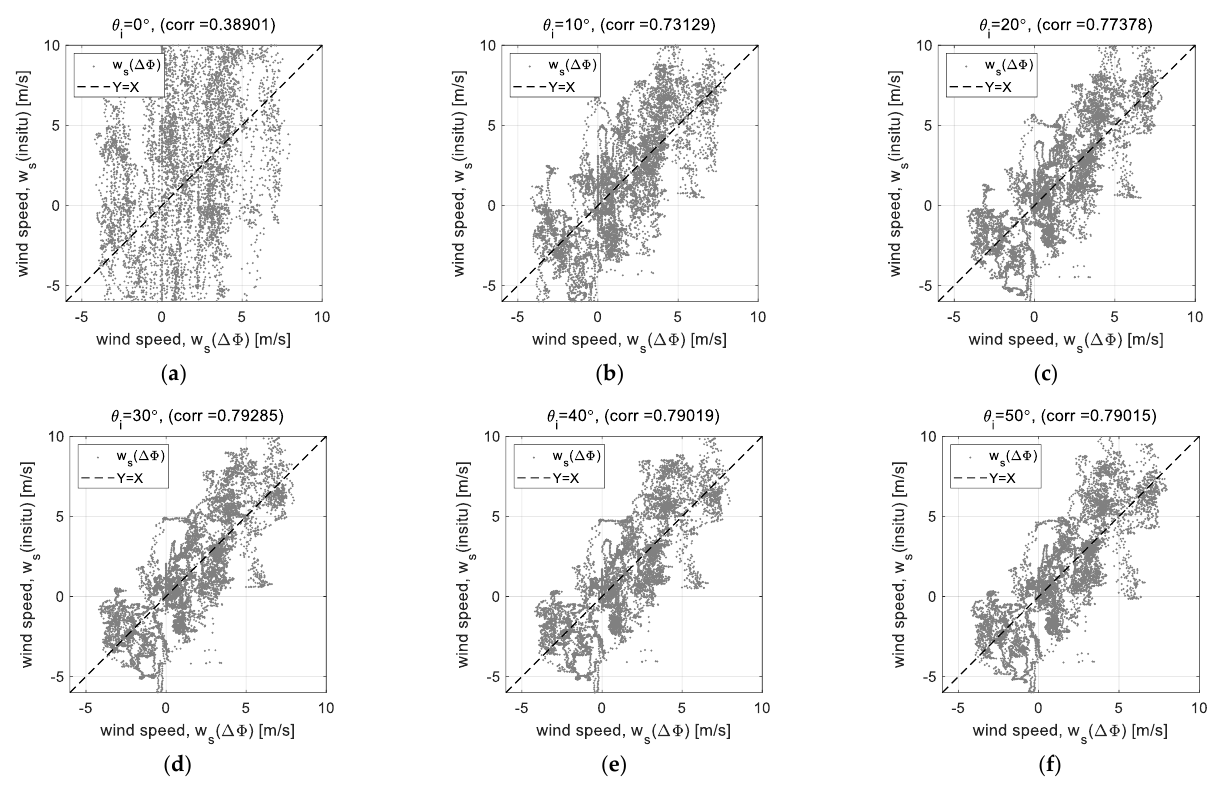
Figure 9. Results of the linear regression analysis of self-interferometric phase ( ∆Φ ) to wind speed: ( a – f ) correlation diagrams at each incident angle.